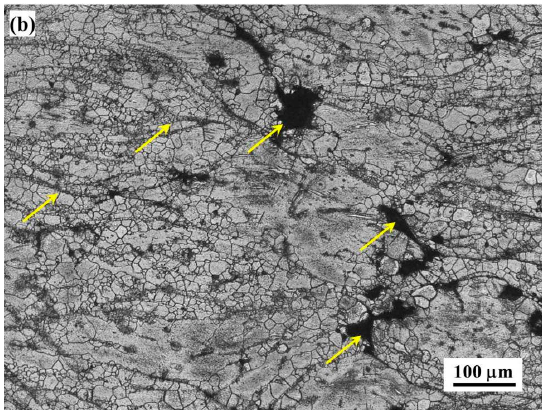
Figure 9. Optical micrographs of deformed specimens at: ( a ) 260 °C/1 s − 1 exhibiting extensive shear band and ( b ) 420 °C/0.1 s − 1 exhibiting flow localization. The compression axis is vertical.